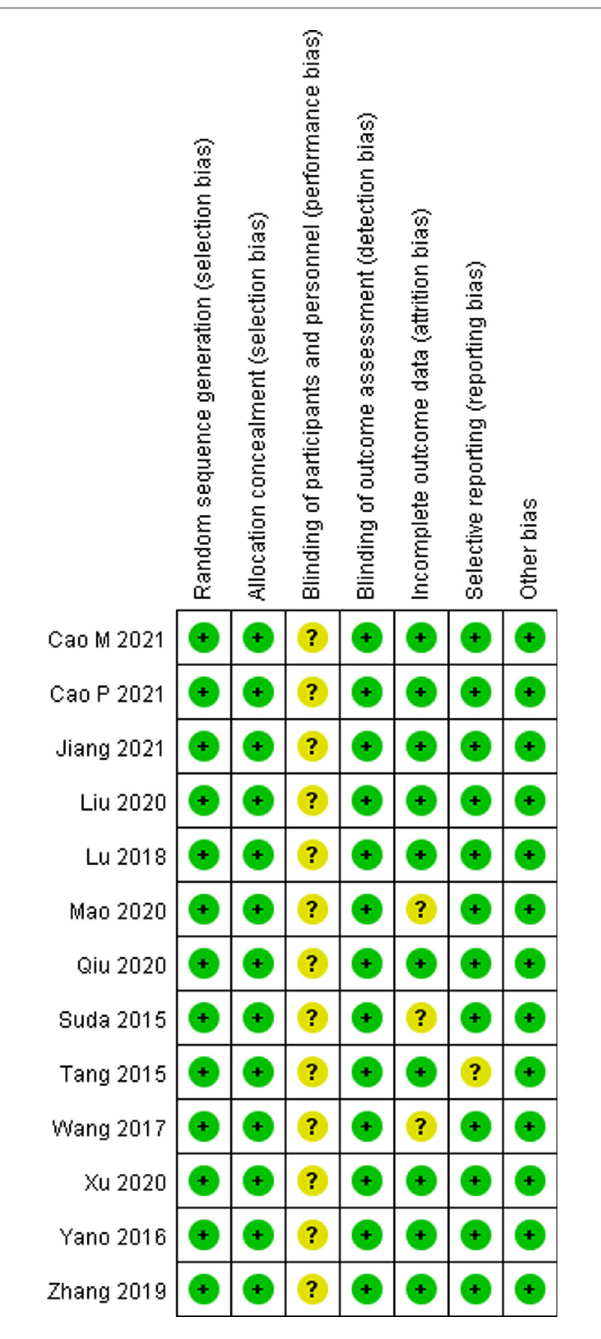
Figure 8 . The VAS score of the SVAT group was signi fi cantly lower than that of the IVATS group on the day after the